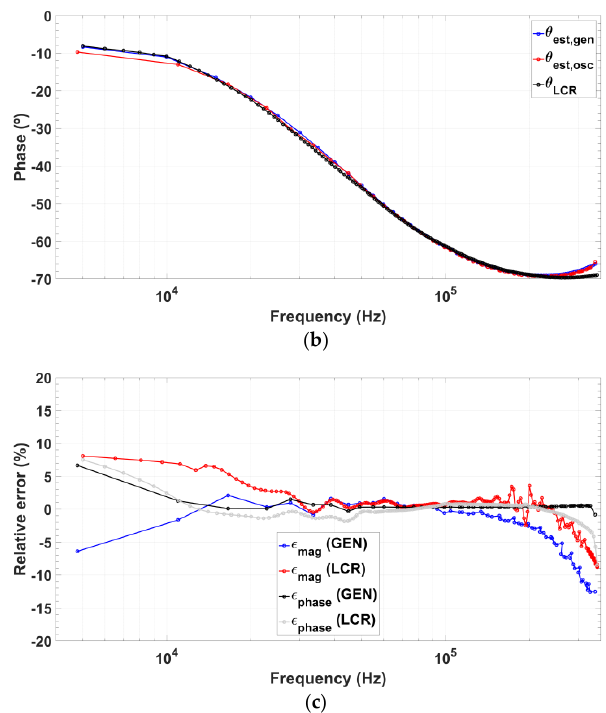
Figure 15. Impedance measurement applying input quadrature signals generated by the fabricated oscillator prototype (red), commercial waveform generator (blue) and commercial 8101G LCR meter (black): ( a ) Impedance magnitude recovery; ( b ) Impedance phase recovery; and ( c ) Recovery errors for both magnitude and phase using the proposed integrated oscillator compared to the results applying the commercial AWG and the values measured by the LCR-meter.